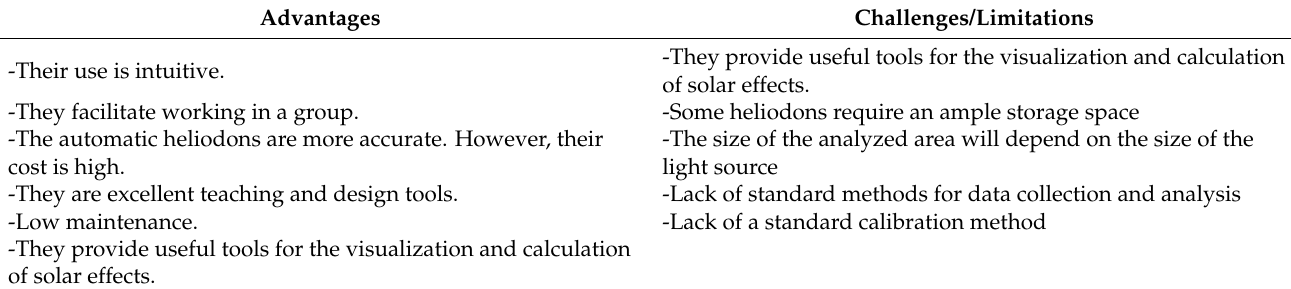
Table 1. Advantages and challenges of heliodons.